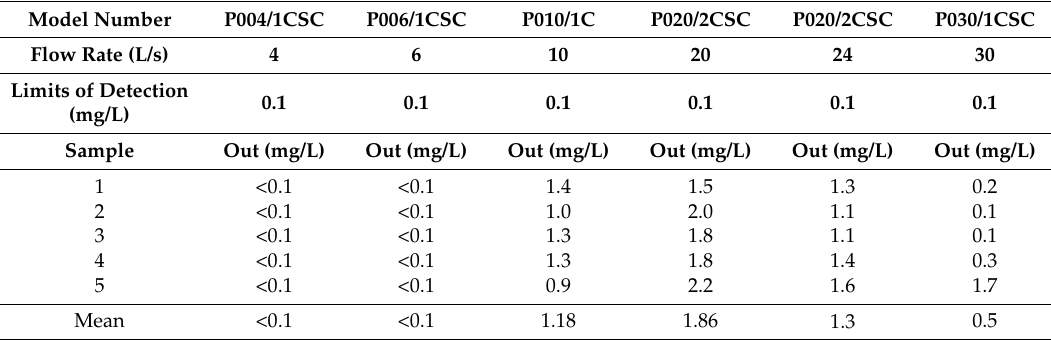
Table 2. University of South Australia Water Quality Results.